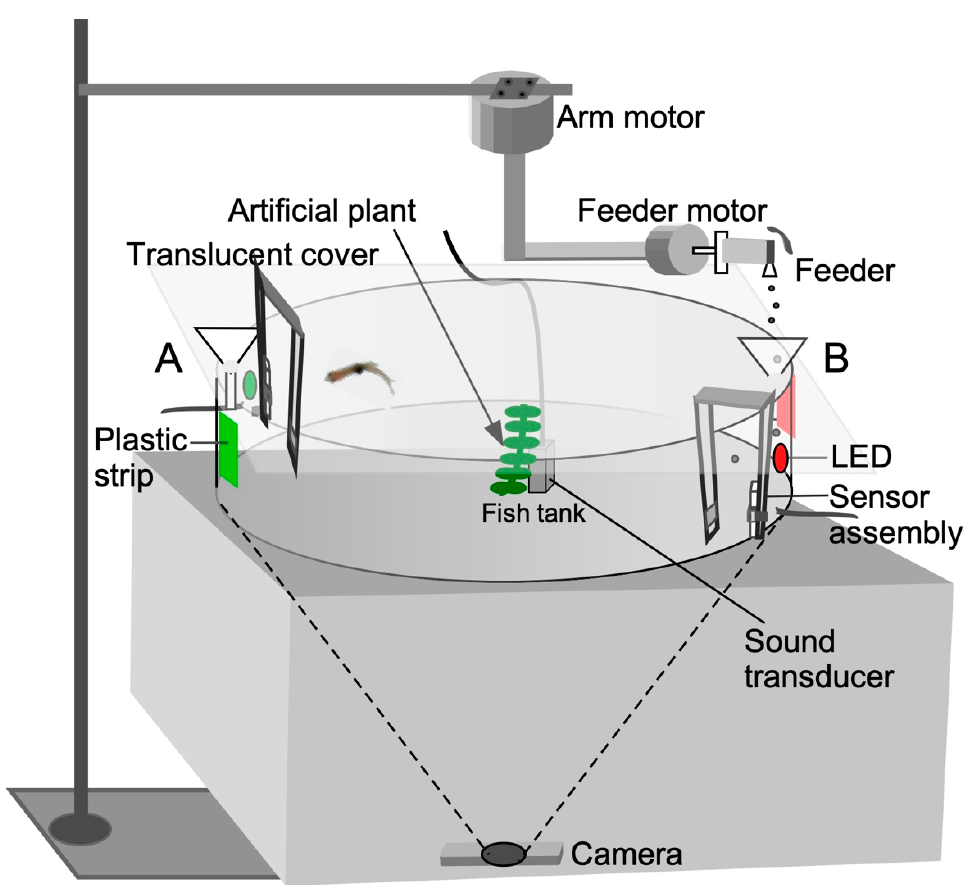
Figure 1. Diagrammatic representation of the audio-visual training apparatus for operant condi- tioning. For classical conditioning, a sensor trigger is not required. Fish-training/testing trials on stimulus-directed swimming were conducted in groups for classical conditioning and individually for operant conditioning. See text for additional details of the setup and Figure 2 for software con- trol.